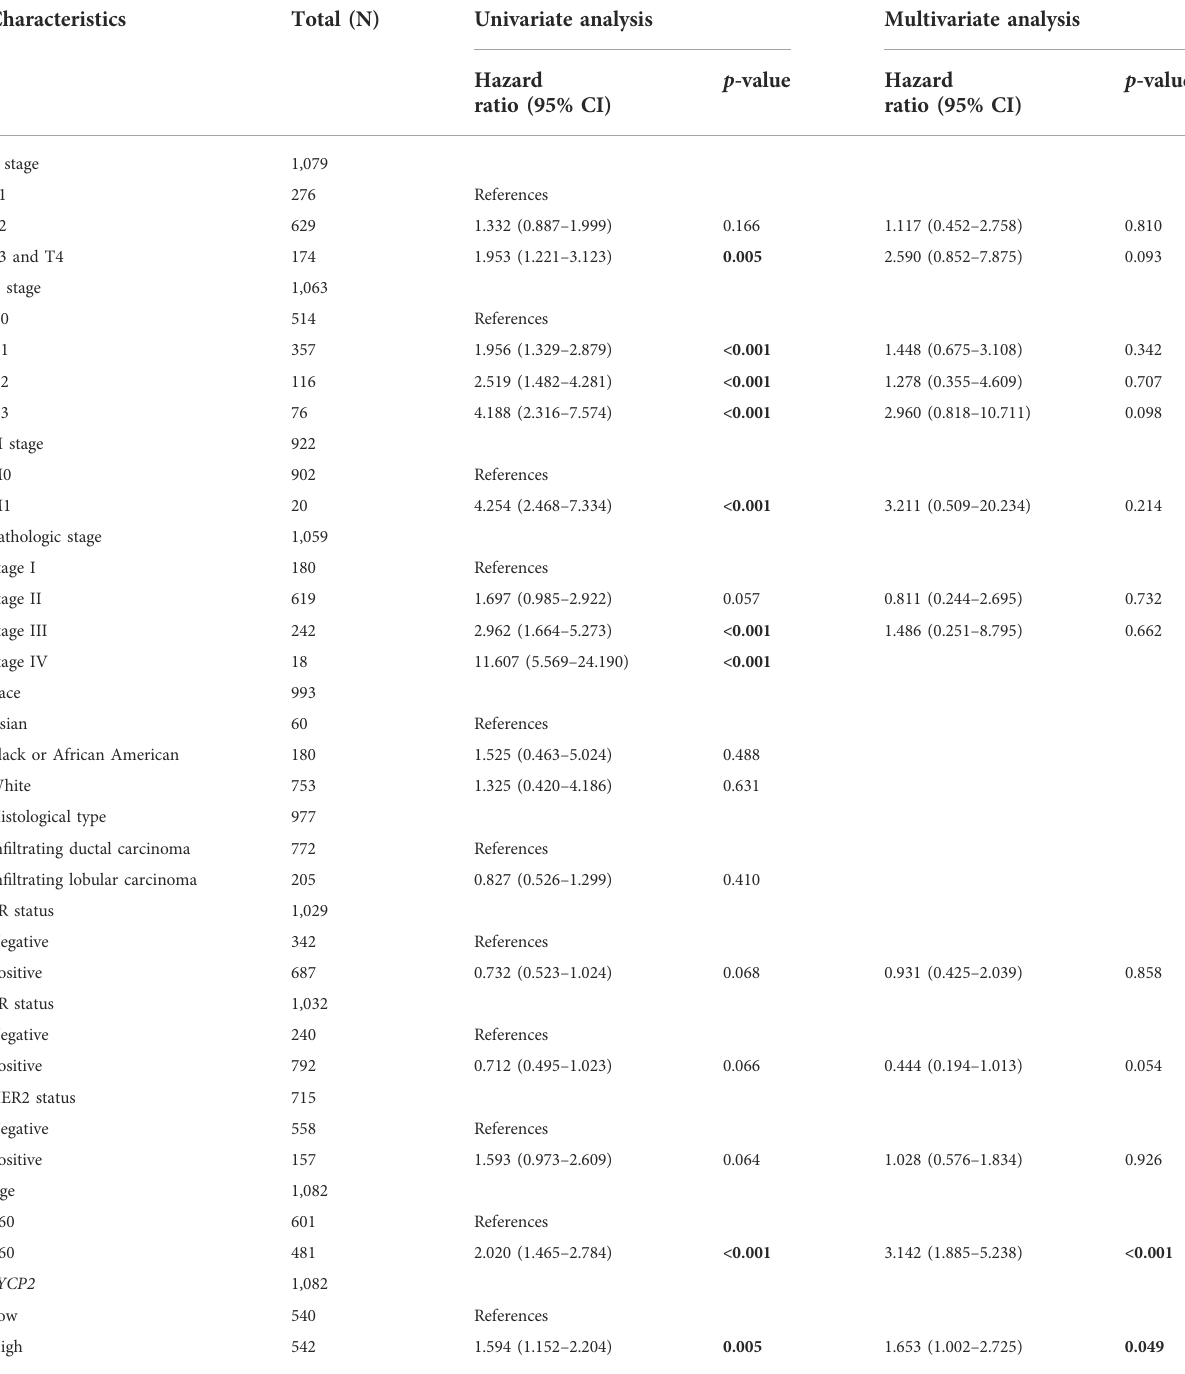
TABLE 5 Univariate and multivariate Cox expression